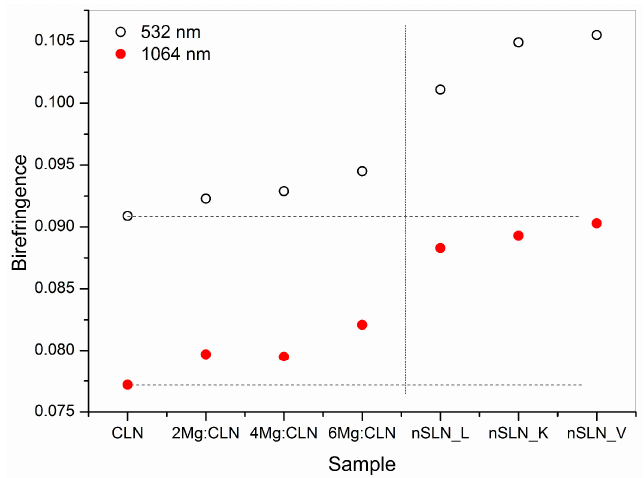
Figure 11. Refractive index ( n o and n e ) of different ( a ) Mg:CLN; and ( b ) nSLN crystals at 532 and 1064 nm wavelength.